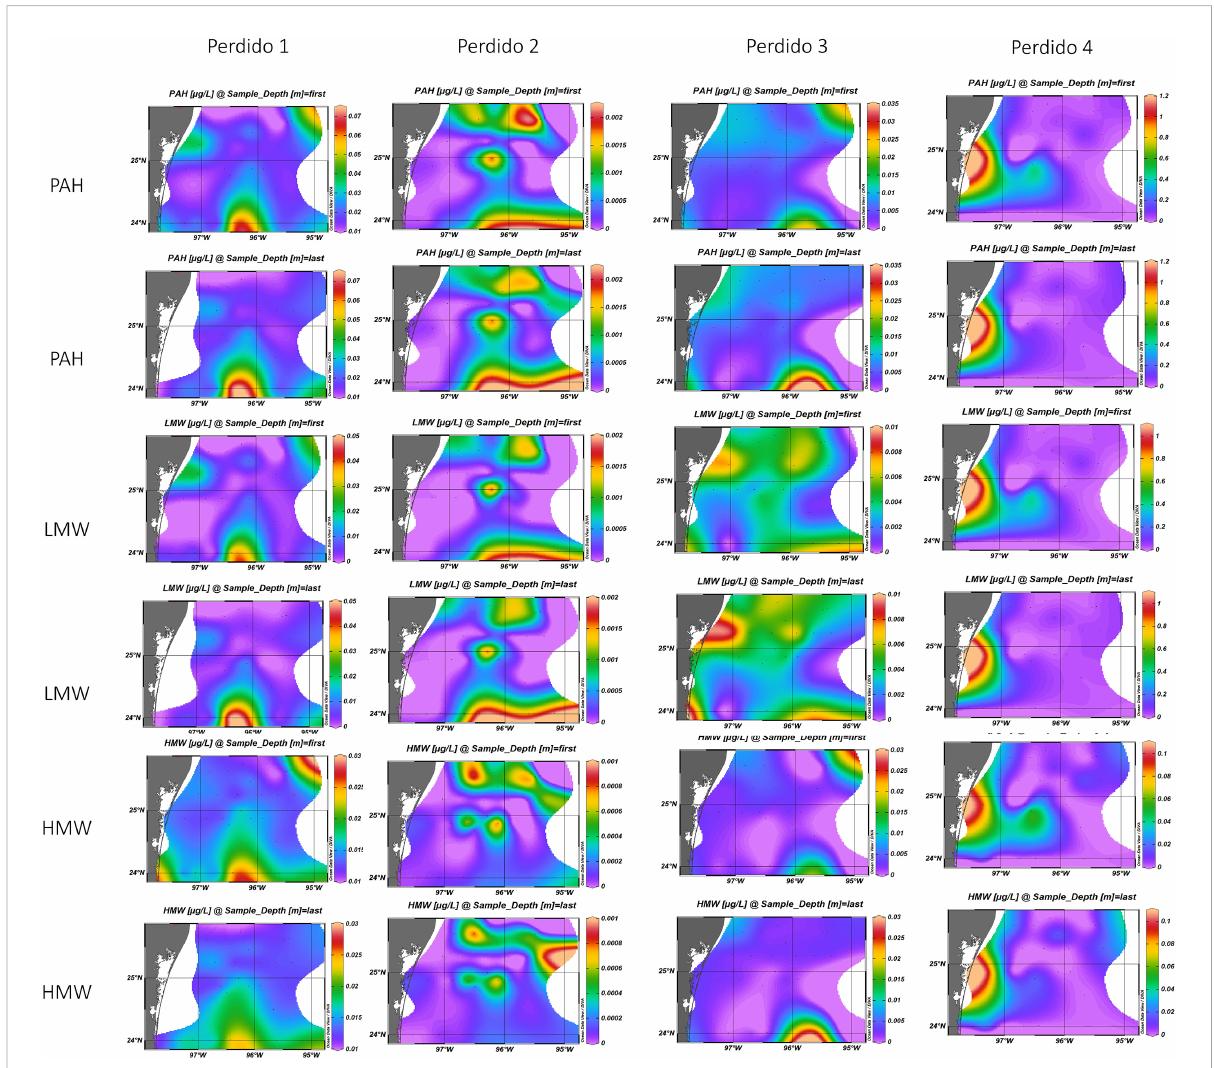
FIGURE 2 Spatial distribution of total polycyclic aromatic hydrocarbons (PAHs), LMW (low molecular weight), and HMW (high molecular weight) for the Perdido 1, 2, 3, and 4 cruises. First = surface sample (ca. 1 – 10 m); Last = bottom sample (please refer to Figure 1 for approximated